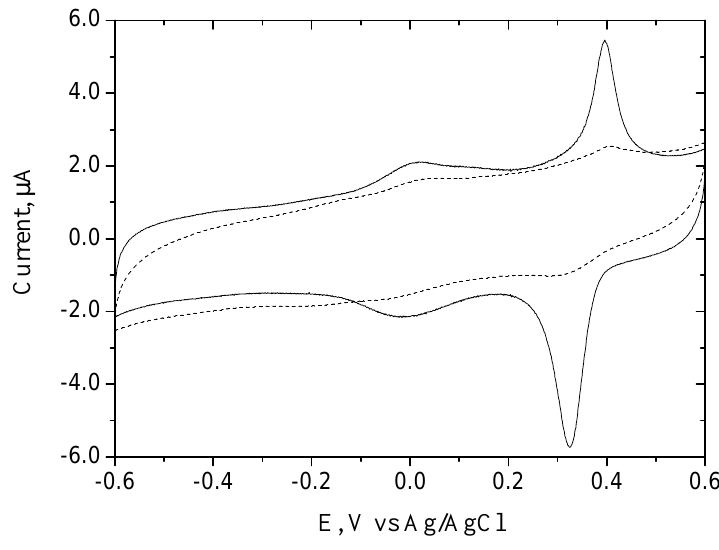
Figure 1. Cyclic voltammetry of GC electrodes coated with PDDA/SPAN (solid line) or SPAN (dashed line), in pH 4.5